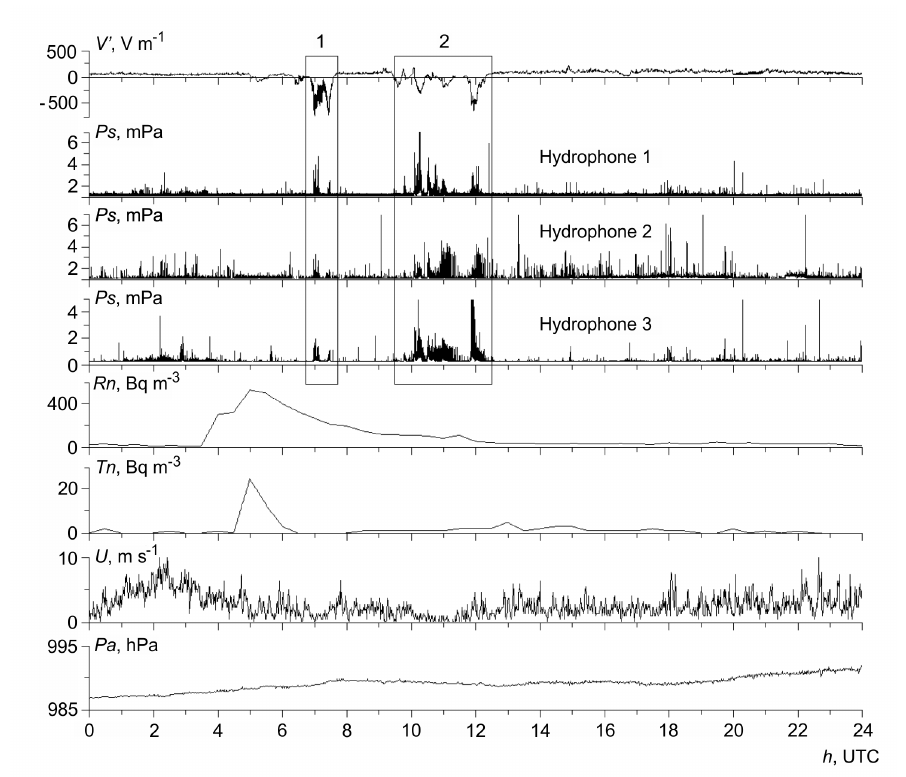
Figure 8. Variations of atmospheric potential gradient V (cid:48) , acoustic pressure P s at three measurement points, those of volumetric activity of radon Rn , thoron Tn , wind velocity U and air pressure Pa on 2 October 2012. 1, 2 are the record fragments of V (cid:48) and P s